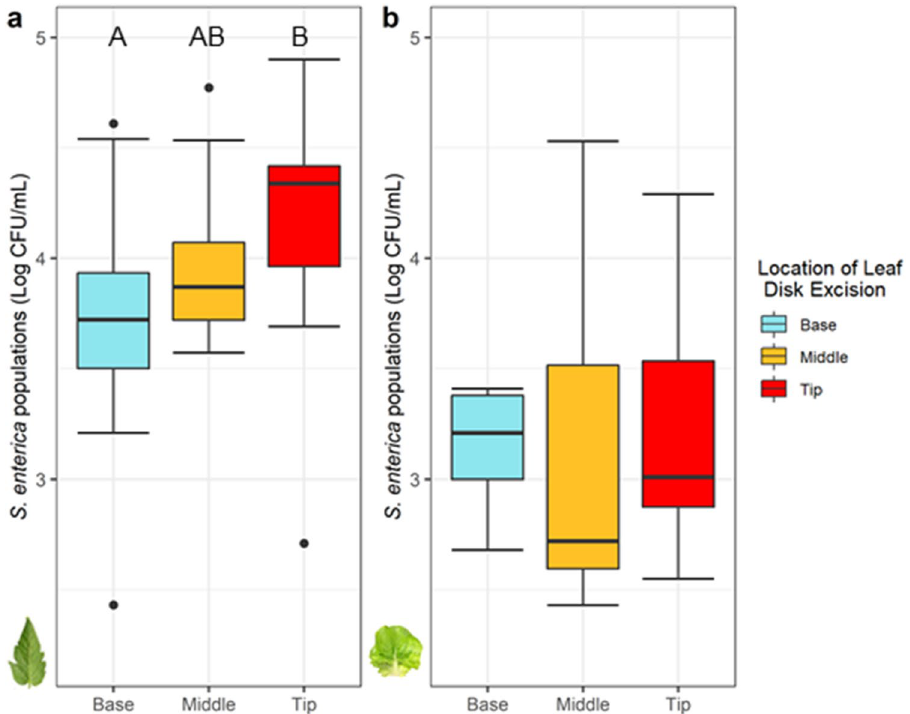
Figure 2. Tomato leaf architecture impacts the distribution of S. enterica populations, unlike lettuce. Salmonella enterica populations were significantly greater at the tip of tomato leaflets than the base ( a ) ( P < 0.05), whereas lettuce leaves have a uniform bacterial distribution ( b ). Leaf discs were excised from pre-determined locations from the basal (blue), middle (orange), and tip (red) regions of leaves. Letters above boxplots indicate